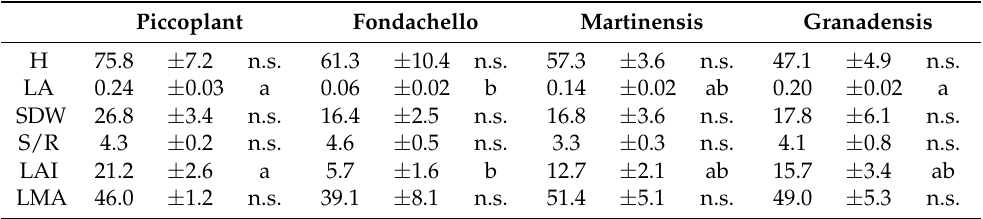
Table 3. Biomass parameters of the four Arundo donax L. clones. H, height (cm); LA, leaf area (m 2 ); SDW, shoot dry weight (g); S/R, shoot root; LAI, leaf area index; LMA, leaf mass area (g · m − 2 ). n.s. non-significant differences in the same parameter between clones. Different lowercases letters mean significant differences in the same parameter between